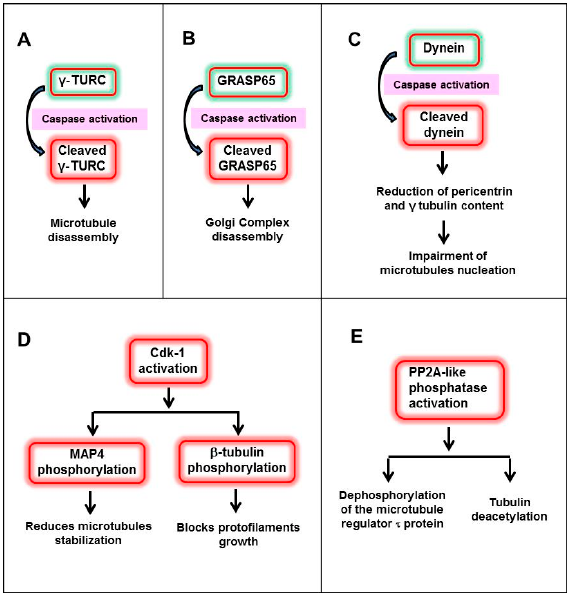
Figure 2. Molecular mechanisms involved in microtubules depolymerisation during the initial stages of irregular-shaped apoptosis: Cleavage of γ -TURC ( A ); cleavage of pericentriolar proteins such as GRASP65 ( B ); cleavage of dynein, a microtubule motor protein ( C ); activation of Cdk1, a kinase which regulates several microtubule effectors ( D ); and PP2A-like phosphatase activation which induces dephosphorylation of the microtubule regulator τ protein and tubulin deacetylation ( E